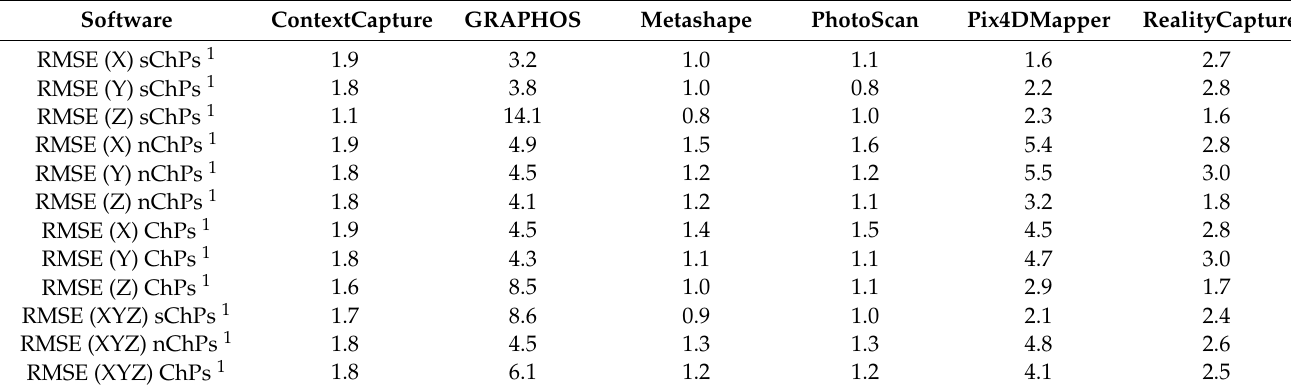
Table 5. The ChPs RMS values obtained in tested software after